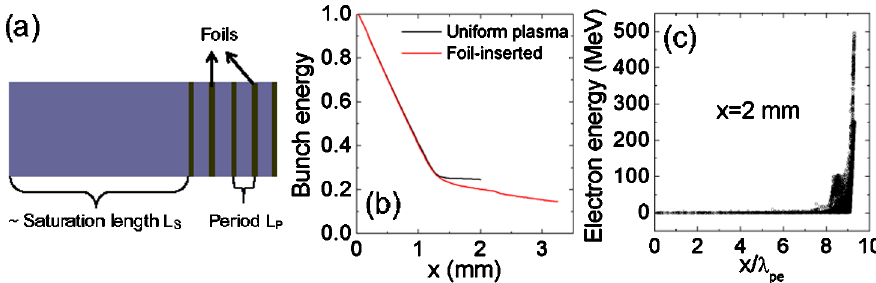
FIG. 4. Suggested beam dump. (a) The structured plasma with periodic thin foils inserted. L p is the separation of the neighboring foils. (b) Bunch energy evolution for both uniform plasma and the structured plasma with L P =(cid:5) pe ¼ 1 , foil length 0 : 1 (cid:5) pe , and density n ¼ 100 n x position at x ¼ 2 mm . foil e . (c) Electron energy vs